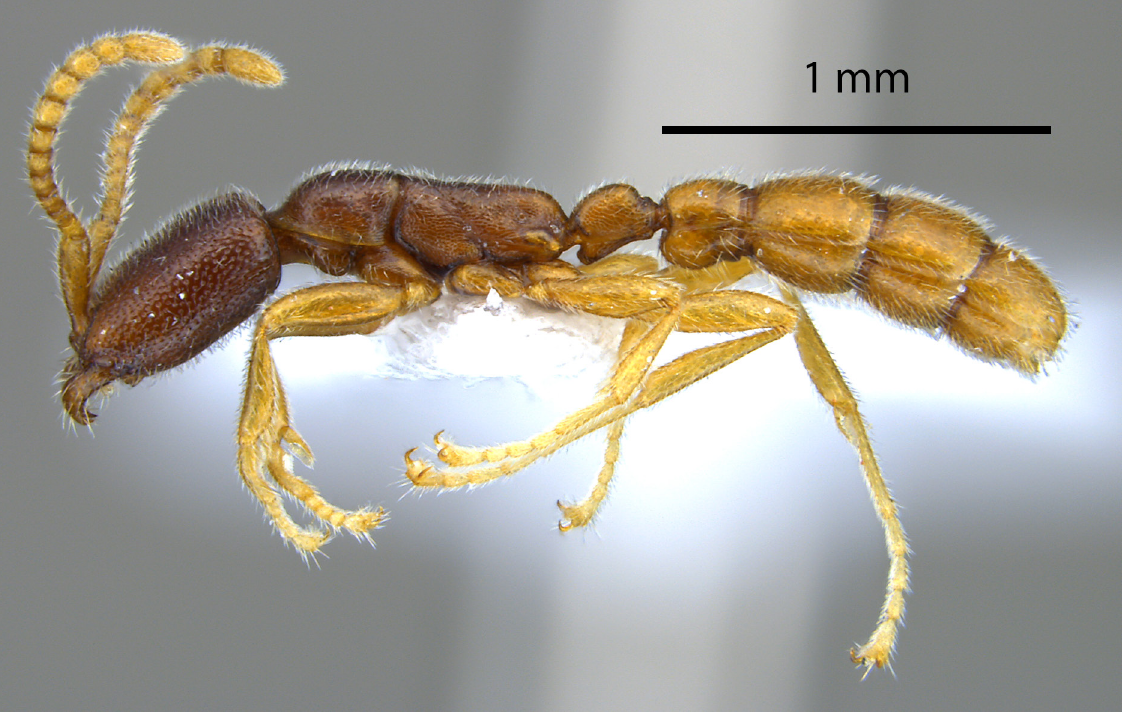
Fig. 5. Habitus in lateral view of paratype (specimen code 4060601) of Leptanilloides prometea Del- sinne & Donoso sp. nov. Note the rounded anterior projection of the subpetiolar process, which differs from the acute shape observed in the specimen on Figs 4C and